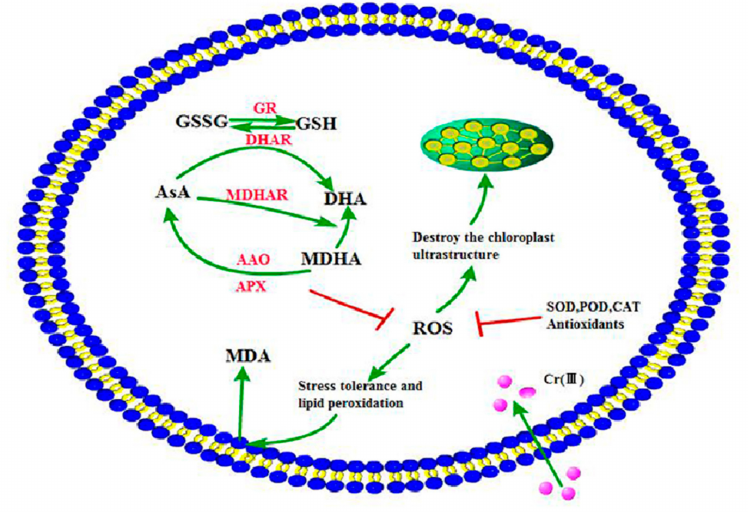
Figure 5. Simplified metabolic and signal transduction pathway of AsA-GSH cycle in regulating Cr accumulation and